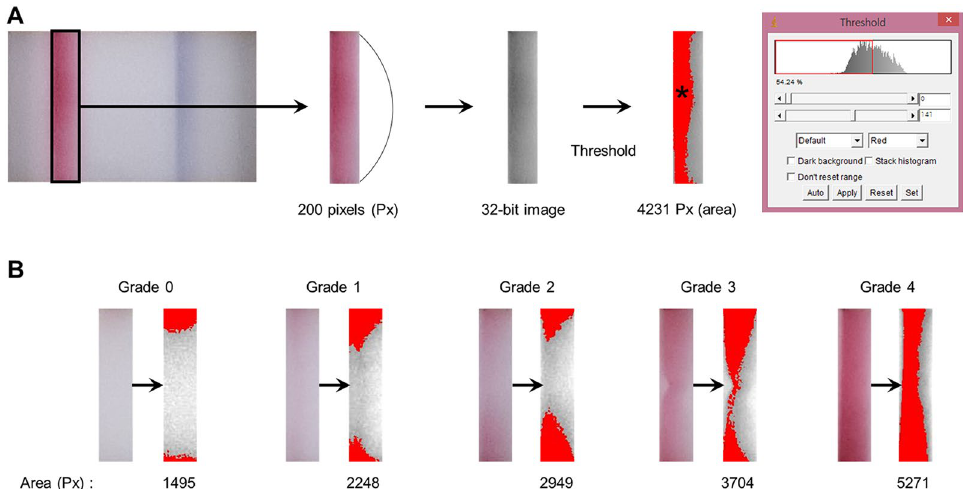
Figure 3. Representative images showing the processes for the quantification of the colorimetric density of the red band in the readout window of the point-of-care matrix metalloproteinase (MMP)-9 immunoassay. ( A ) First, the MMP-9-expressing red band was outlined with a black rectangle, then was cropped. The vertical length was sized into 200 pixels (Px). The image was converted to the 32-bit one and the area with relatively high color density was detected by auto-threshold. The red-colored area (asterisk) was estimated. ( B ) The representative 5 images in each grade before and after the color threshold.